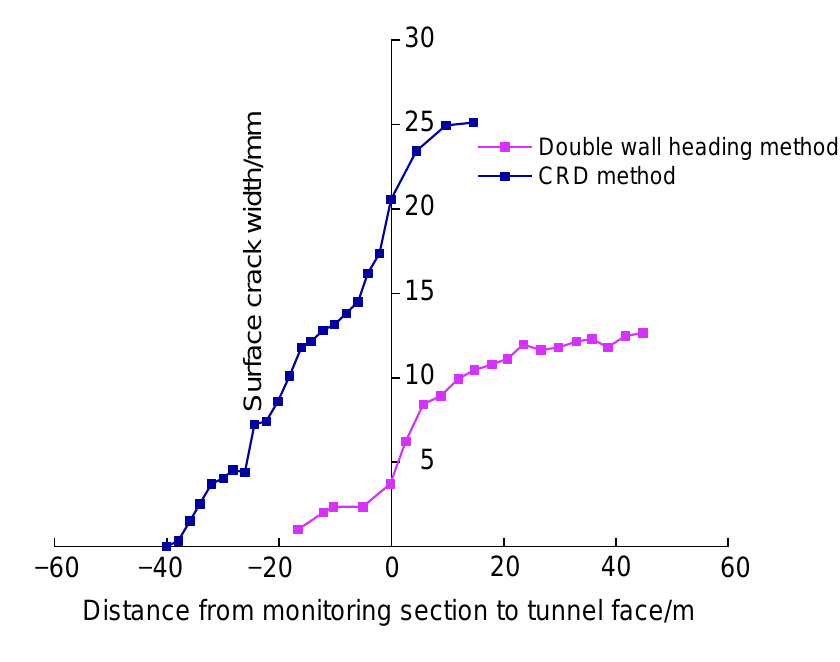
Figure 24. Surface crack propagation process curve [79].